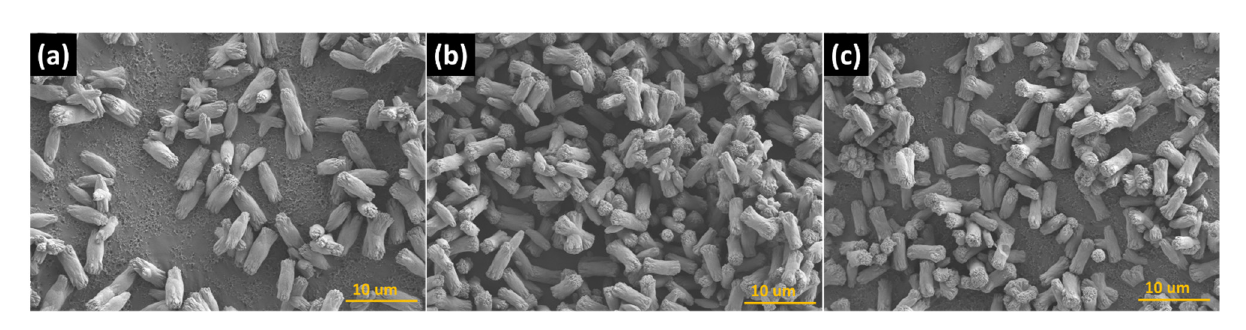
Figure 3. ( a ) Luminescence spectra of SrWO 4 , ( b ) SrWO 4 :Dy 3+ , and ( c ) SrWO 4 :Sm 3+. The FE-SEM images of all samples showed that they all had long cylindrical shapes. For SrWO 4 , the particle size was ~6.2 µm and ~1.92 µm in the longitudinal and transverse direction, respectively (Figure 4a). For the RE-doped SrWO 4 :Dy 3+ , the particle size aver- aged ~5.09 µ m (longitudinal) and ~1.49 µ m (transverse) (Figure 4b), and for SrWO 4 :Sm 3+ , aged ~5.09 µm (longitudinal) and ~1.49 µm (transverse) (Figure 4b), and for SrWO 4 :Sm 3+ , the particles measured ~5.61 µ m (longitudinal) and 1.49 µ m (transverse) (Figure 4c). the particles measured ~5.61 µm (longitudinal) and 1.49 µm (transverse) (Figure 4c).